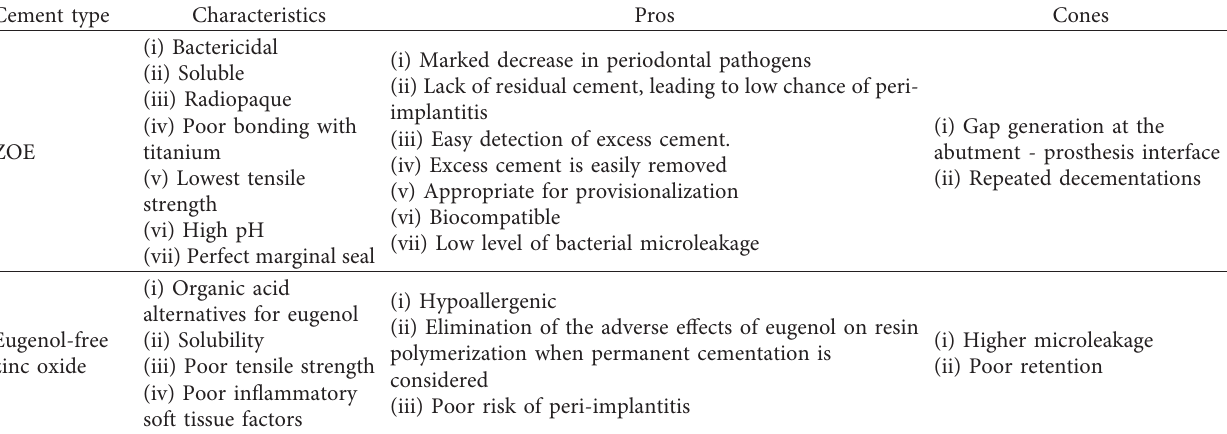
Table 1: Provisional cements [48].